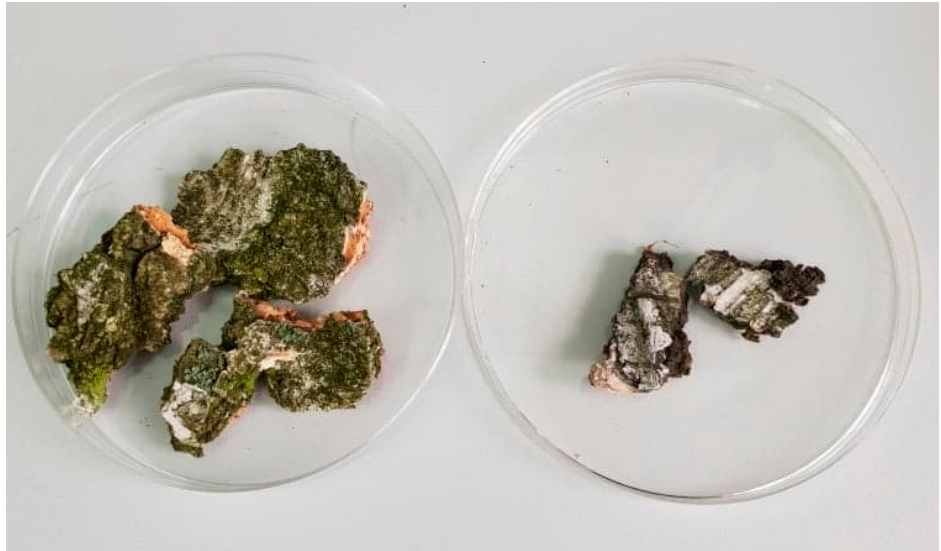
Figure 2. Betula obscura Kotula (left) and Betula pendula Roth (right) outer